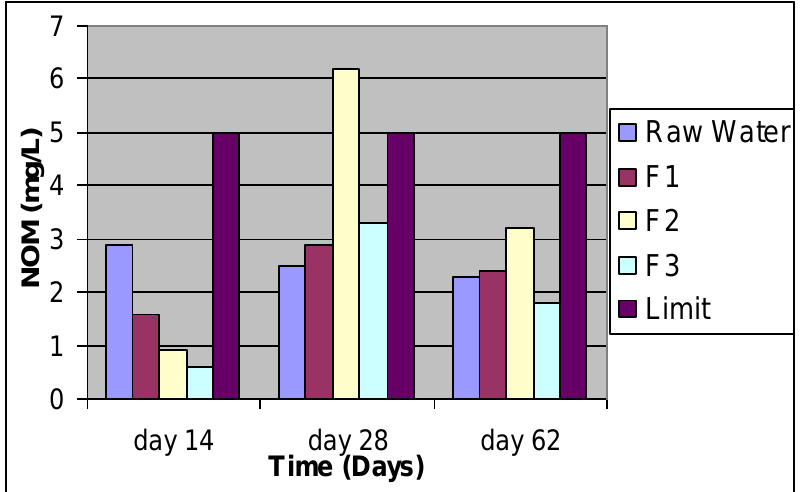
Figure 3. Natural organic matter levels as measured by permanganate